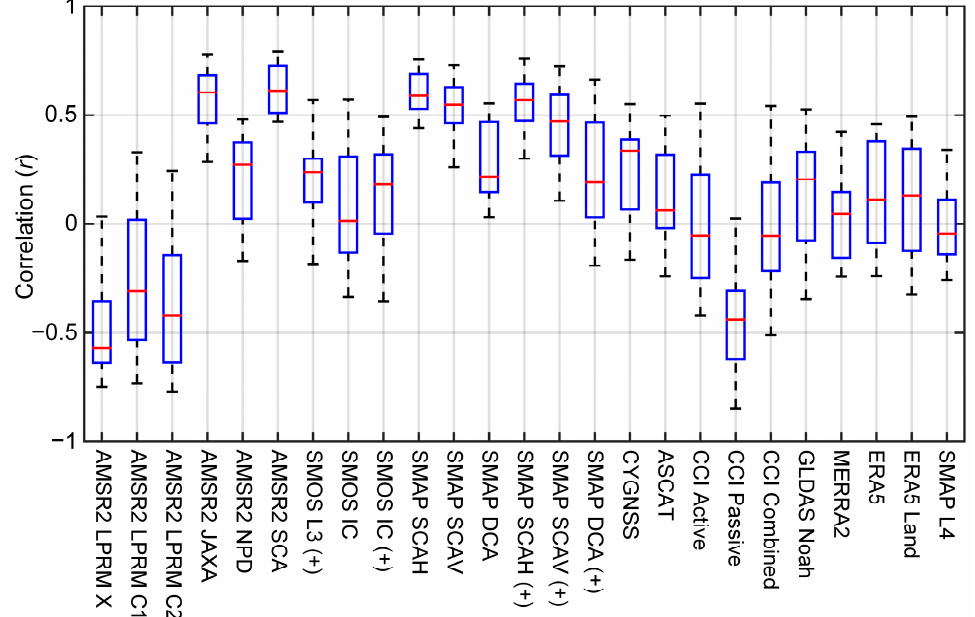
Figure 10. Correlations between soil moisture bias (gridded minus in situ soil moisture) and irrigation water use on monthly scales. Each boxplot shows the distribution of correlation coefficient values at the 20 stations, including the maximum, 75% quartile statistics, median, 25% quartile statistics and the minimum. The symbol “(+)” means a relaxed flagging strategy for L-band products.